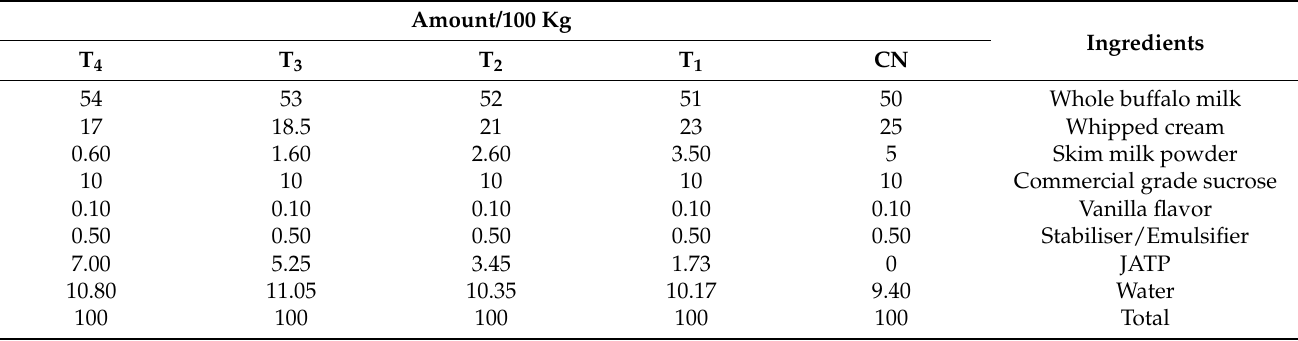
Table 1. Formulation of frozen yoghurt mixes (% w / w